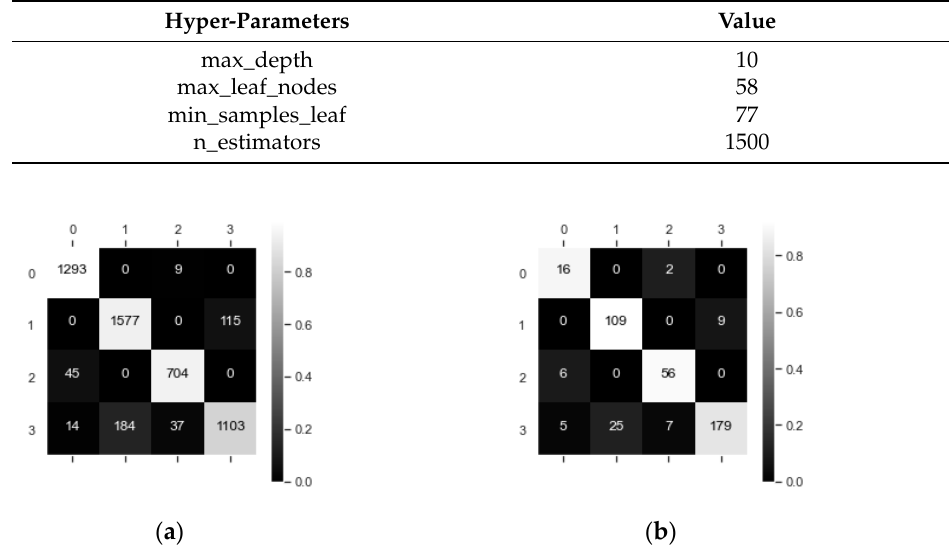
Figure 17. ( a ) Confusion matrix of samples (Random Forest1); ( b ) Confusion matrix of ships (Random Forest1).